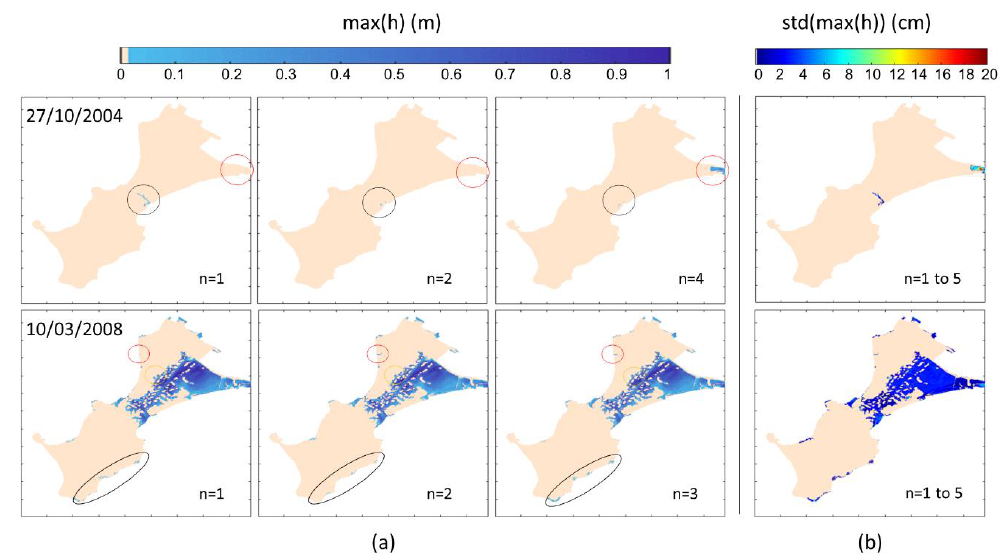
Figure 6. Instantaneous water level (denoted  ) at the southern boundary (point P, Figure 1) of the computational domain of the SWASH model, for the 27/10/2004 ( a ) and 10/03/2008 ( b ) events, with 5 simulations per event.